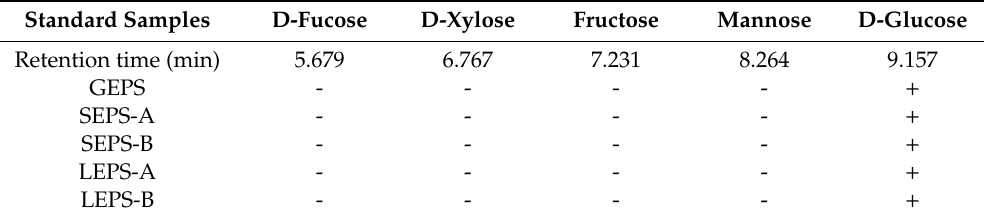
Table 3. Monosaccharide composition of